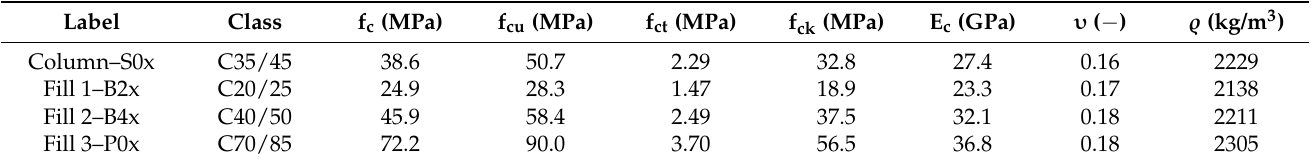
Table 3. Properties of concrete—mean values.